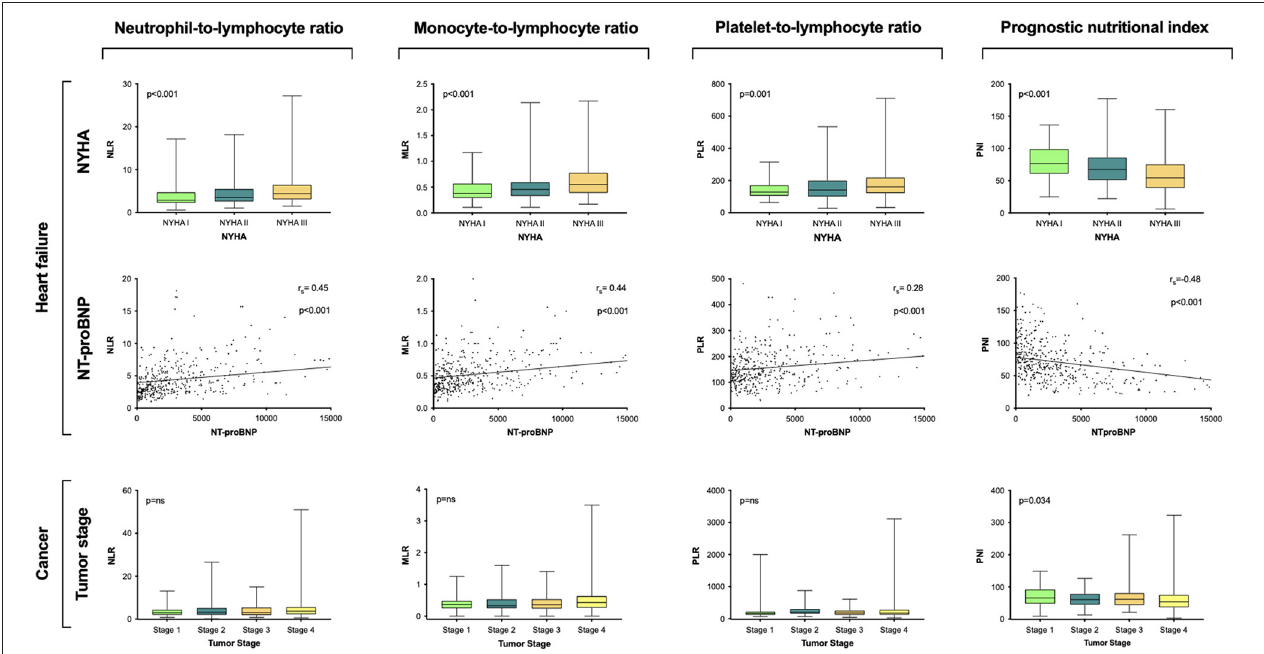
FIGURE 1 | Association of assessed risk scores with disease severity. Group comparisons between respective risk score with NT-proBNP, NYHA classification, and tumor stage were calculated by Spearman-Rho correlation and Kruskal–Wallis test, respectively. Levels are displayed as Tukey boxplots. Scatter plots depict the relation between NT-proBNP and assessed scores NLR, MLR, PLR, and PNI. NT-proBNP, N-terminal pro B-type natriuretic peptide; NYHA, New York Heart Association; NLR, neutrophil-to-lymphocyte ratio; MLR, monocyte-to-lymphocyte ratio; PLR, platelet-to-lymphocyte ratio; PNI, prognostic nutritional